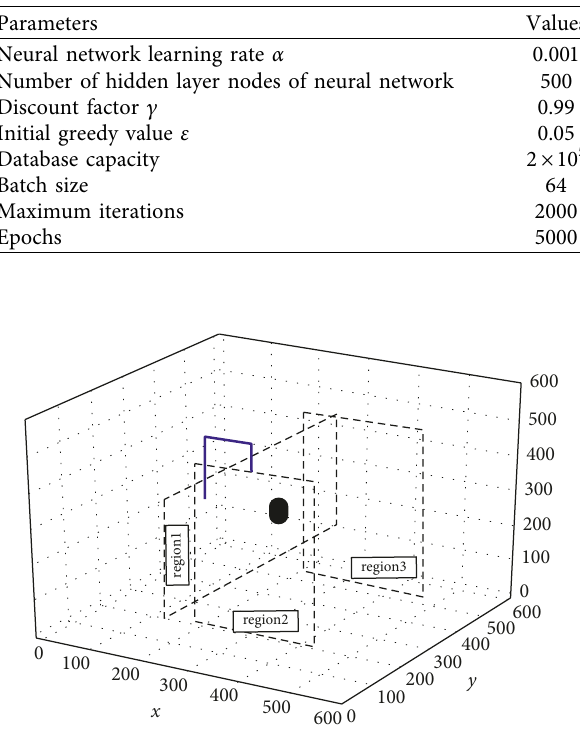
Figure 4: Simulation model of the live working operation in power distribution